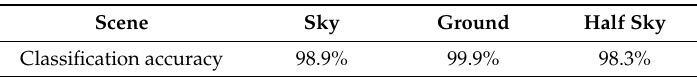
Table 1. Recognition accuracy